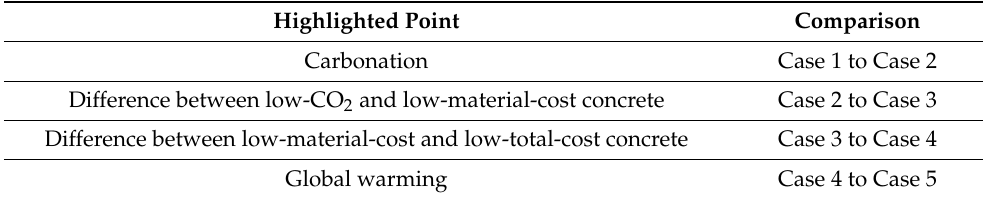
Table 5. Highlighted points of design cases.